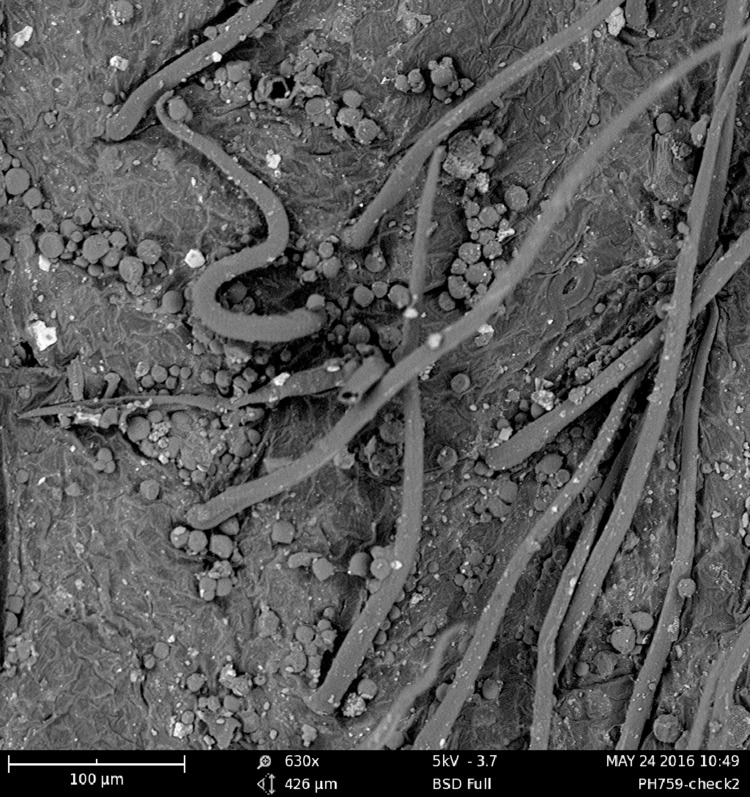
Photomicrograph of microbes in tea fermentation.Scale bar represents 100μm.